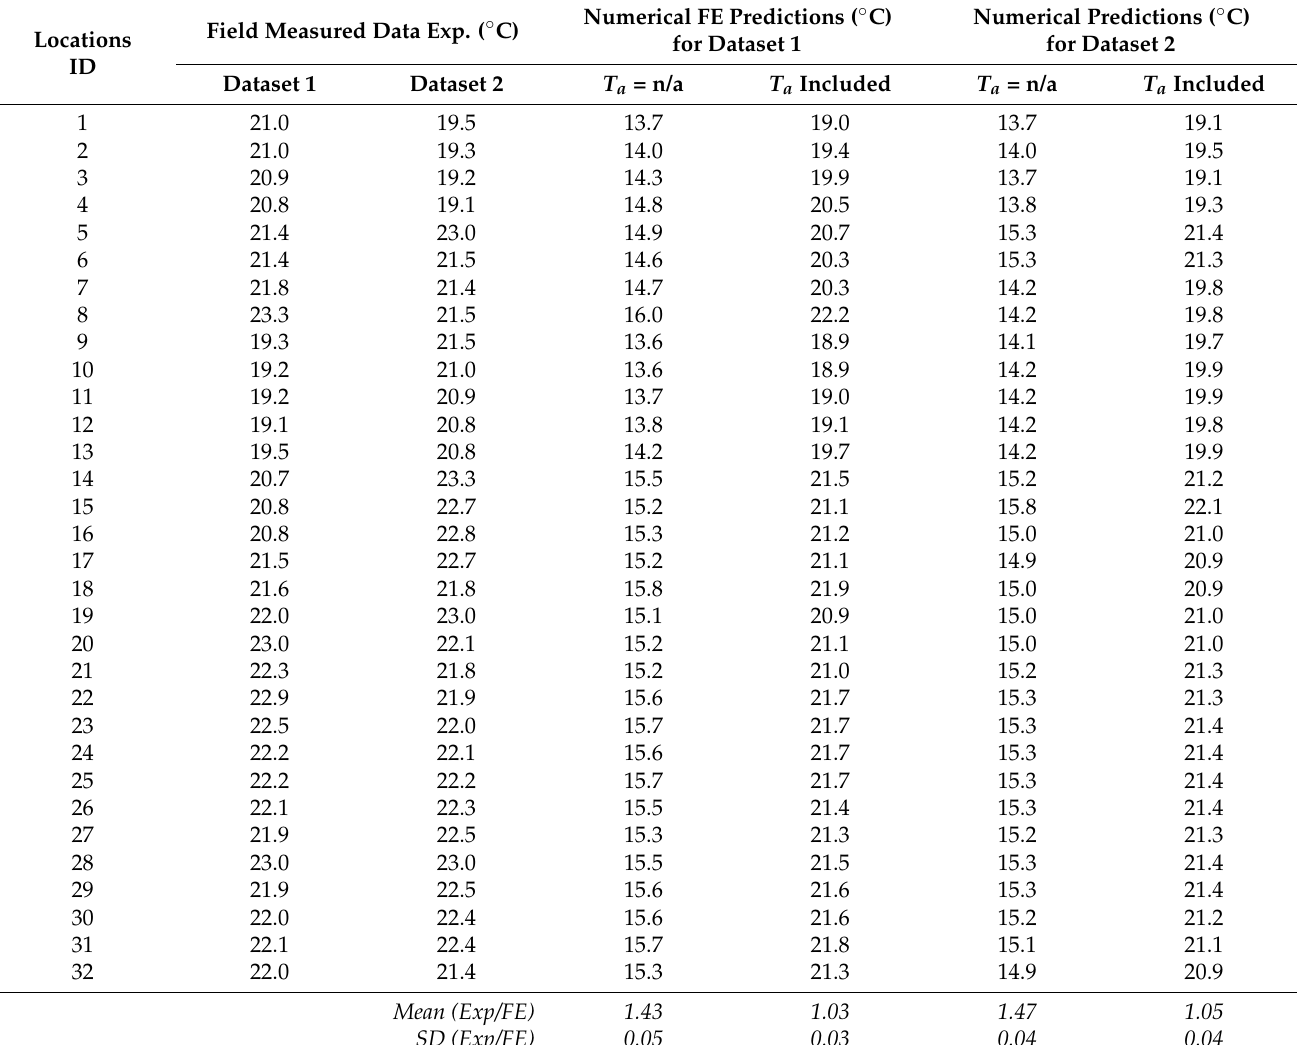
Table A1. Predicted temperature at bottom of concrete slab and field